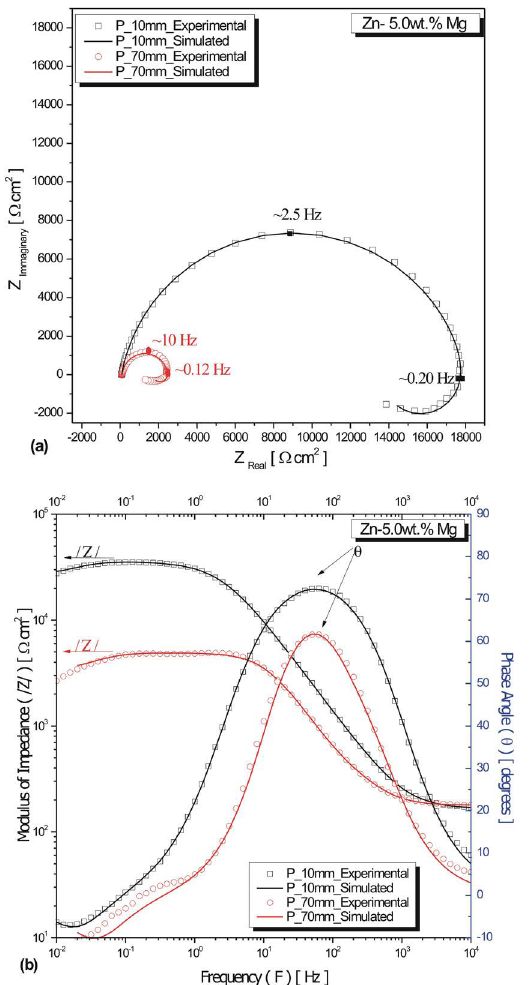
Figure 8. Comparison of the experimental and simulated CNLS results for the Zn-5.0wt.%Mg alloy samples P_10mm and P_70mm: (a) Nyquist graphs; High frequencies values indicated at the semicircles are related to the maximum imaginary component; while low frequencies values are related to the start of the inductive behavior. (b) Bode and Bode-phase graphs; The arrows indicate the maximum angle (ɵ) and the impedance module (/Z/) values.